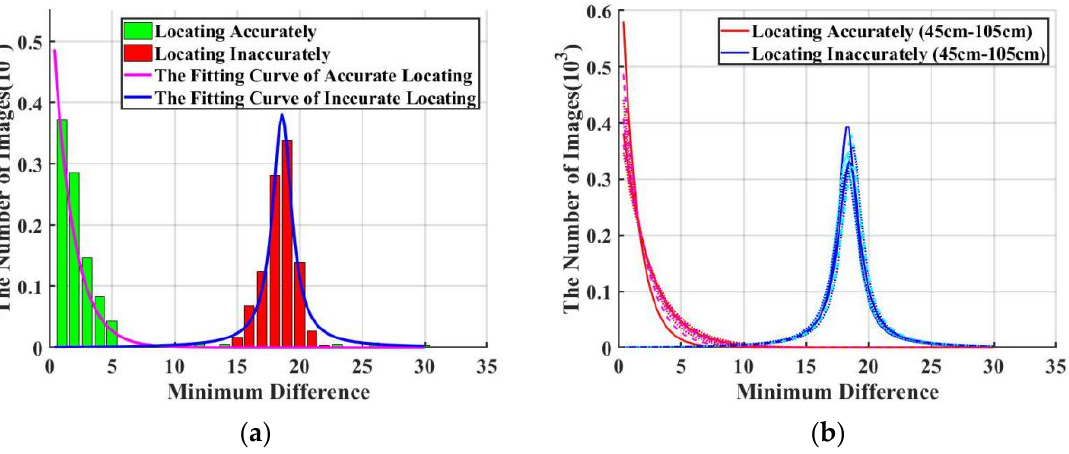
Figure 11. Minimum Difference (MD) value distributions and fitting curves: ( a ) The MD value and